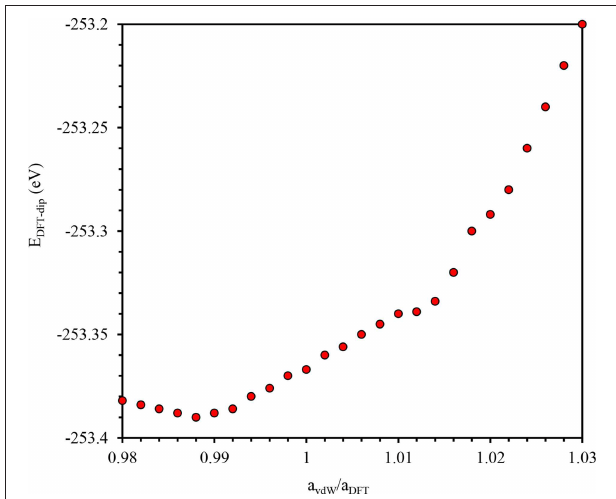
FIGURE 2 | E DFT − disp Calculated in VASP as function of lattice parameter ratio a vdW / a DFT